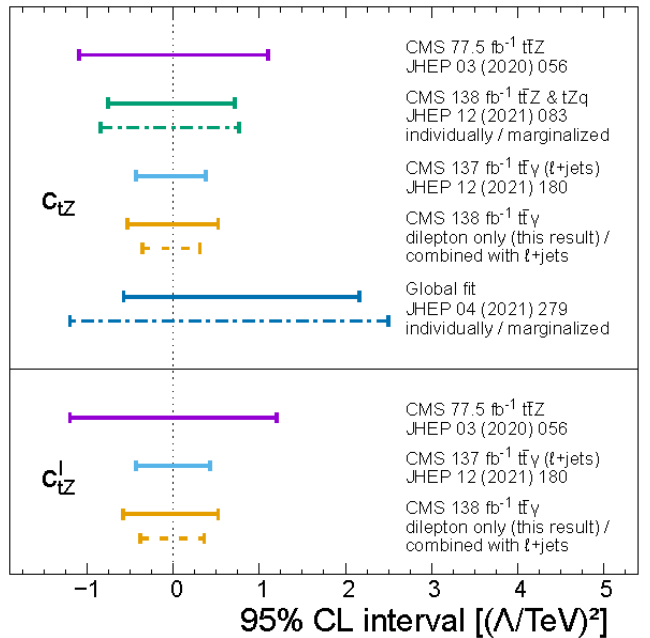
Figure 26. Comparison of observed 95% CL intervals for the two Wilson coefficients, c tZ ( upper panel ) and c tZI ( lower panel ) from CMS measurements of: t¯t Z , t¯t γ single lepton, t¯t γ dilepton. The results are shown from the one-dimensional scans, i.e., all other Wilson coefficients have values set to zero. The dashed lines indicate the results from the combination with the single − lepton channel. In the case of the global fit and the t¯t Z + tZq , the solid lines represent the result where all Wilson coefficients are fixed to zero, whereas the dashed lines show the results from the marginalised